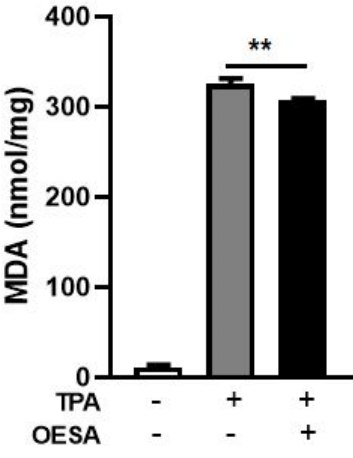
Figure 4. MDA assay: effect of OESA on MDA production in Raji cells after 48 h induction of viral cycle. Raji cells were exposed, or not, to TPA (8 nm) and OESA (0.31 mg/mL) simultaneously at a noncytotoxic concentration of 0.3 mg/mL. The levels of MDA produced was evaluated by the determination of thiobarbituric acid reactive substances. The data were expressed in nmol/mg of protein (**: p < 0.01). Results were expressed as mean ± standard deviations (n = 3). To further confirm the role of OESA as a scavenger of lipid peroxidation, DC levels were measured after the induction of the lytic cycle. DC was produced during the initial stages of lipid oxidation and by breaking down the polyunsaturated fatty acids. Raji cells, untreated or treated with TPA alone or in combination with OESA (0.3 mg/mL). Our data showed a significant reduction in DC levels in Raji cells after EBV lytic cycle induction ( p < 0.05) (Figure 5).